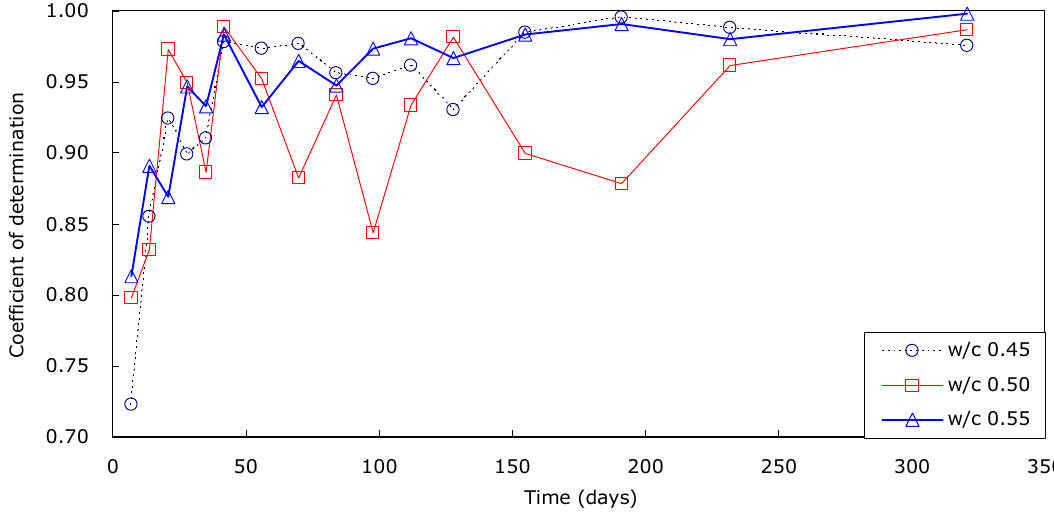
Figure 9. Coefficient of determination in the linear regression deriving from the resistivity ratio vs. chloride concentration.